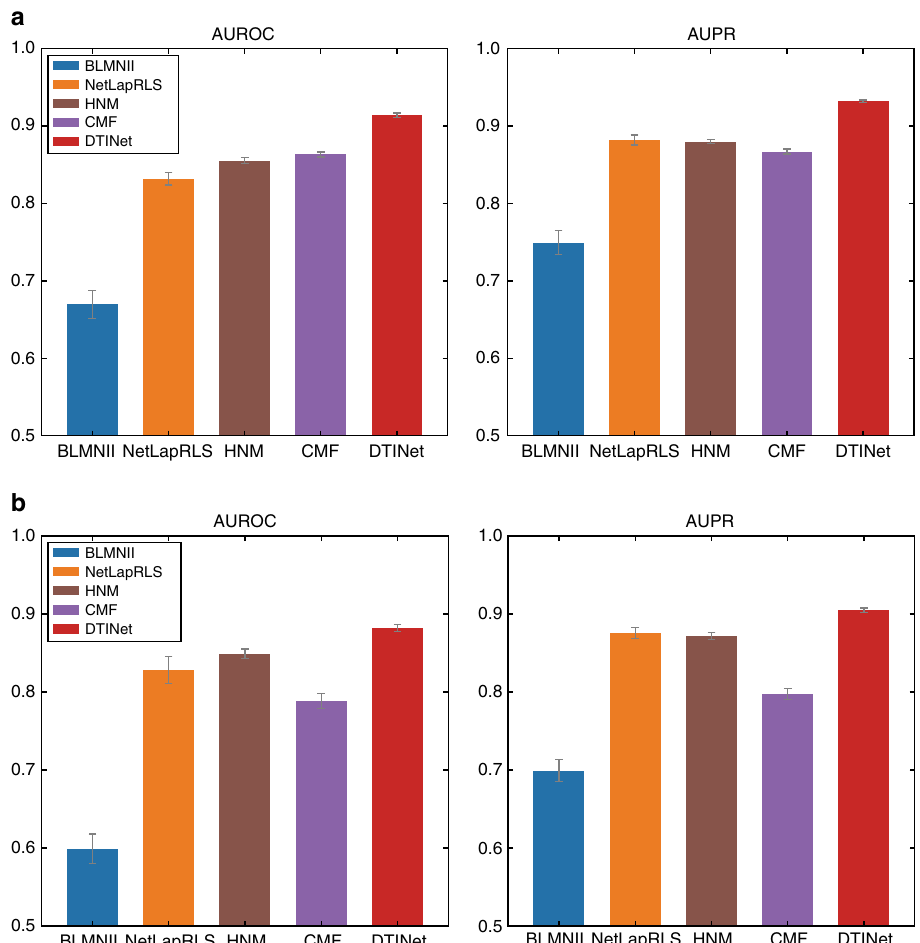
Fig. 3 DTINet outperforms other state-of-the-art methods for DTI prediction. We performed a ten-fold cross-validation procedure to compare the prediction performance of DTINet to that of four state-of-the-art DTI prediction methods, i.e., HNM, CMF, and the extended versions of BLMNII and NetLapRLS (see Supplementary Note 1). Performance of each method was assessed by both the area under ROC curve (AUROC) and the area under precision-recall curve (AUPRC). a All methods were trained and tested on the original collected data set (see the main text), without removing any homologous protein. b All methods are trained and tested on a modi fi ed data set, in which homologous proteins were excluded. A pair of two proteins are said to be homologous if their sequence identity score is above 40%. All results were summarized over 10 trials and expressed as mean ±